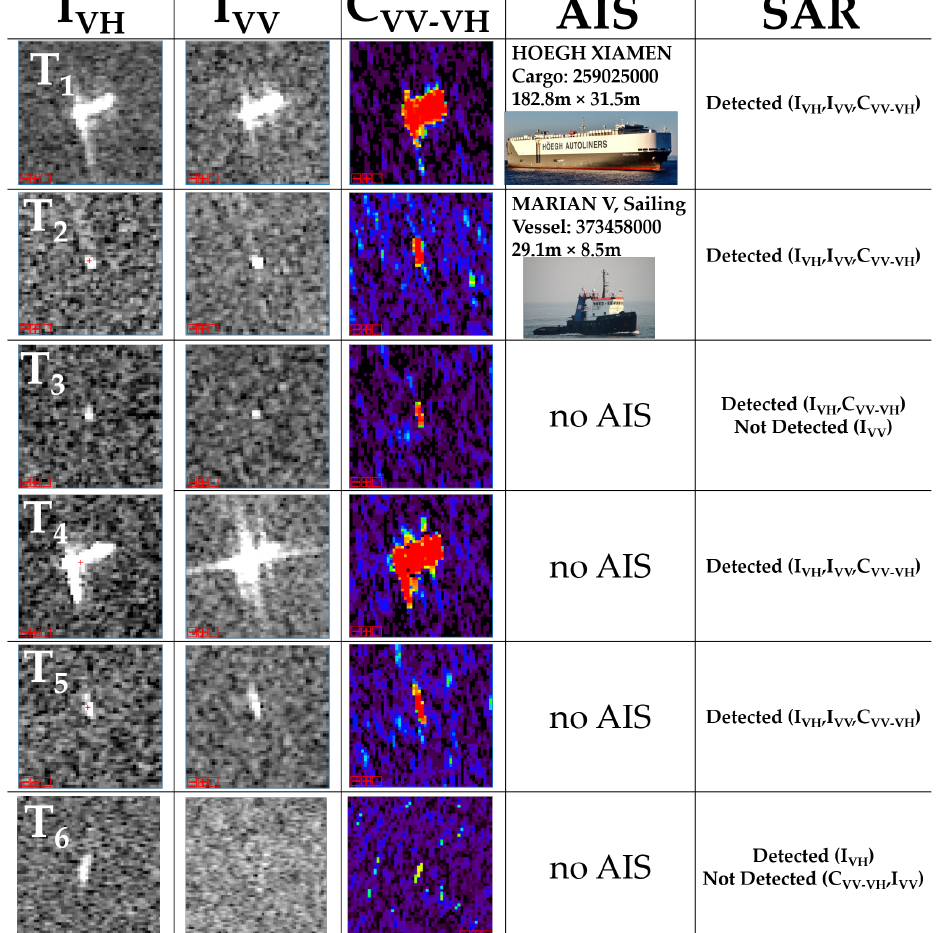
, I VV and I VH VV − VH